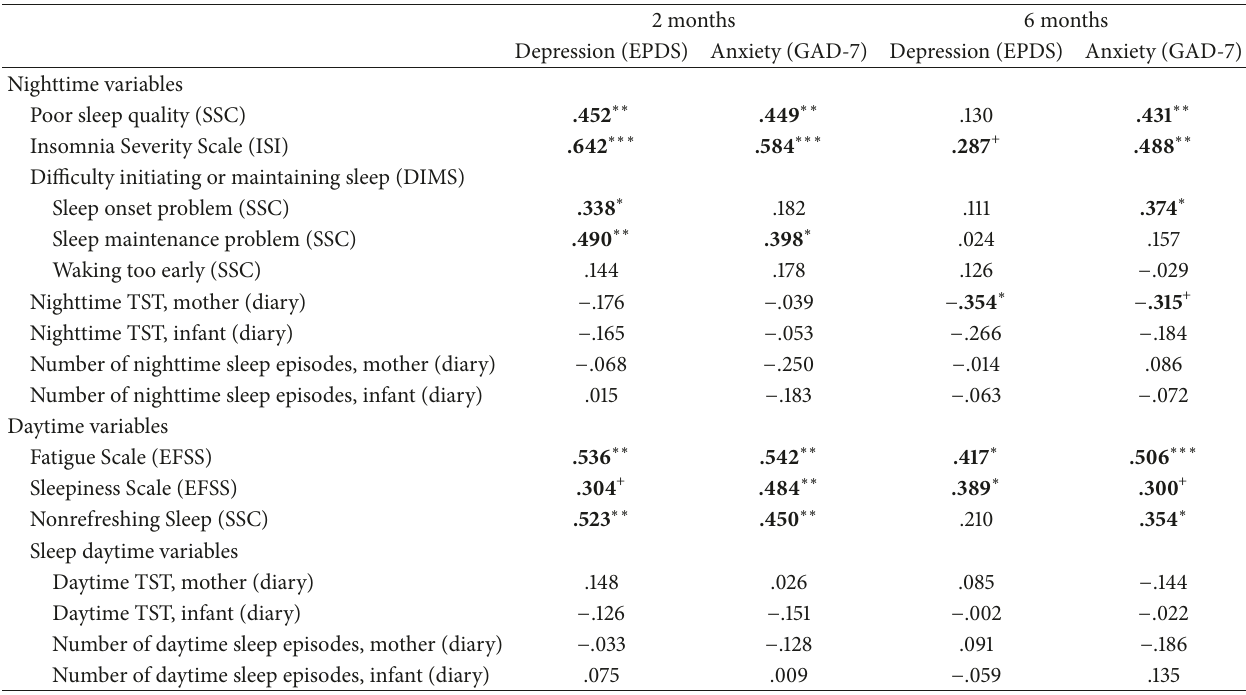
Table 5: Correlations of depression and anxiety with mothers’ daytime and sleep characteristics and with infants’ sleep